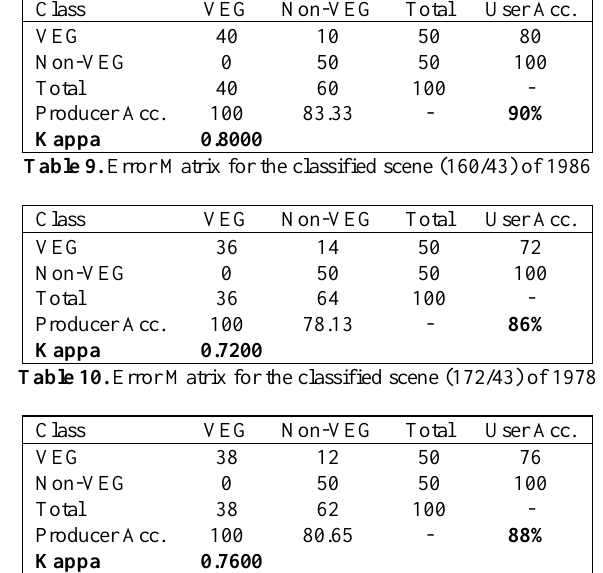
Table 11. Error Matrix for the classified scene (172/43) of